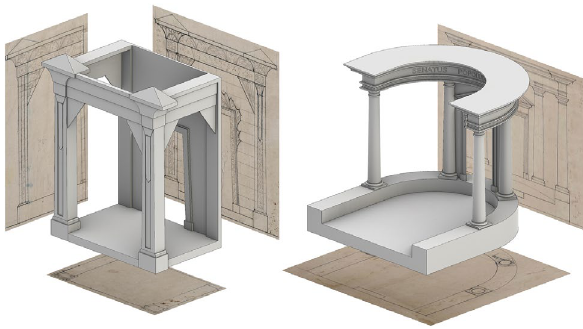
Figure 9 . Re-source based virtual reconstruction (1950’s Pilato . © A. Tomalini